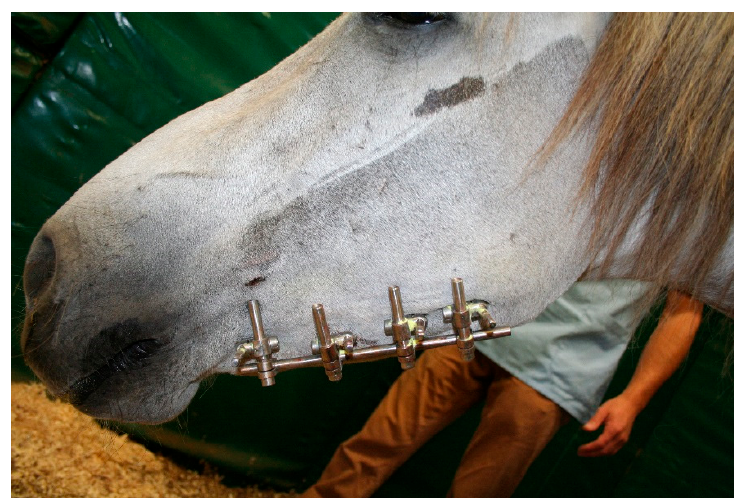
Figure 6. Equine head with unilateral external fixator used during the treatment of the mandible fracture.